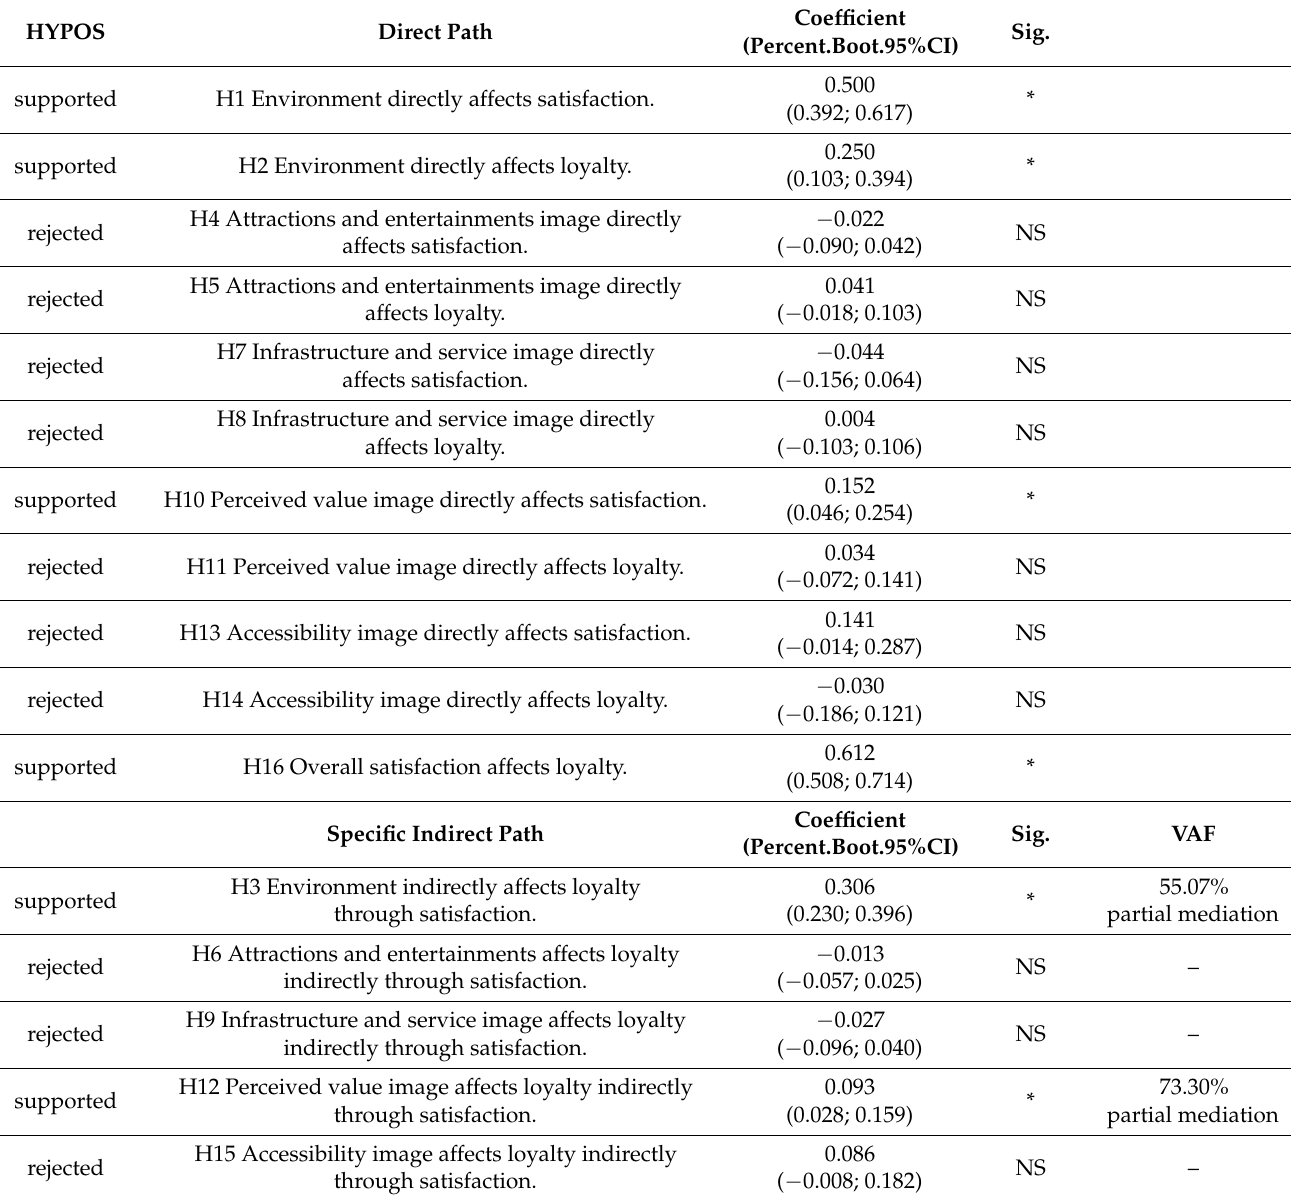
Table 7. Direct, indirect and total effect concerning to model for Malaga